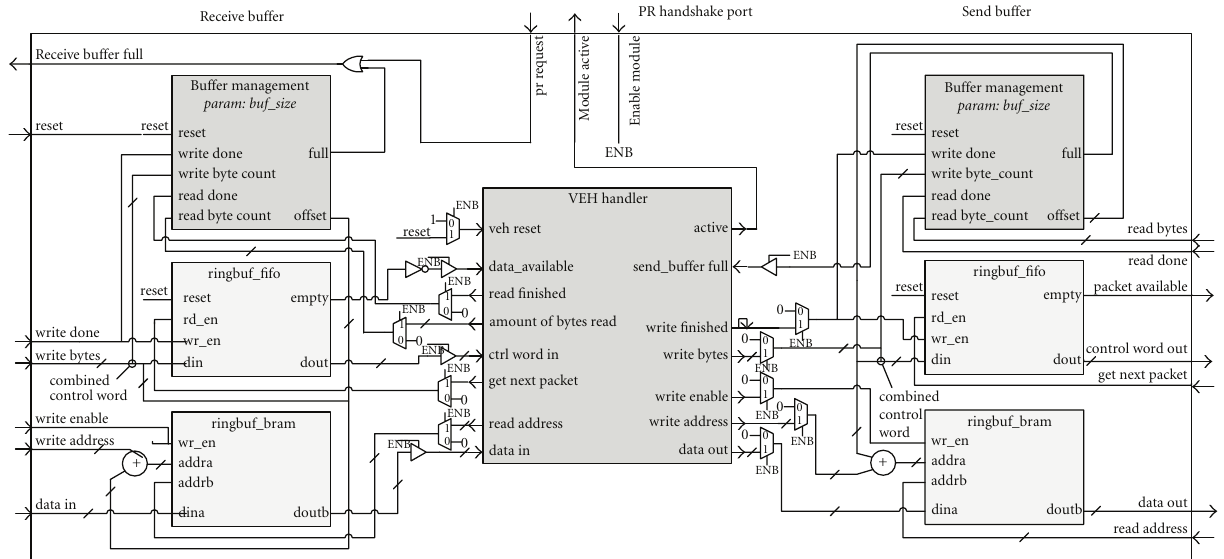
Figure 3: Wrapper encapsulating a vulnerability emulation handler slot.